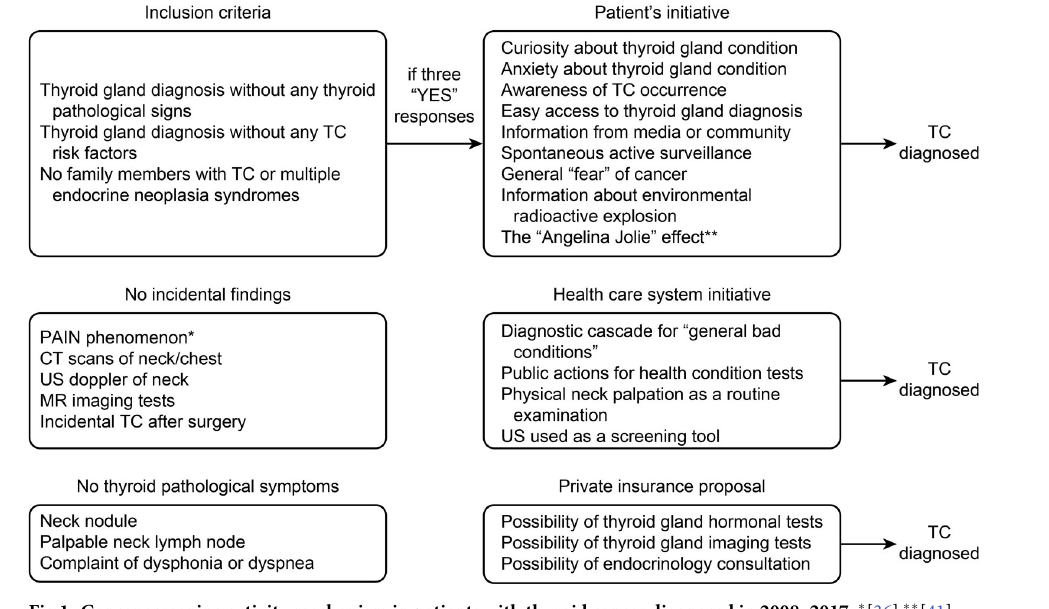
Fig 1. Cancer screening activity mechanism in patients with thyroid cancer diagnosed in 2008–2017. � [36] ��